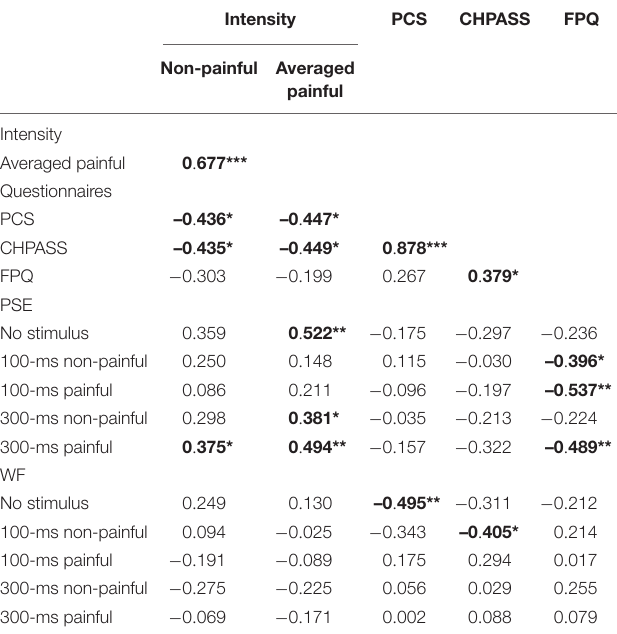
TABLE 1 | Coefficients of correlation ( r ) among stimulus intensity, pain-related scale scores, and temporal bisection